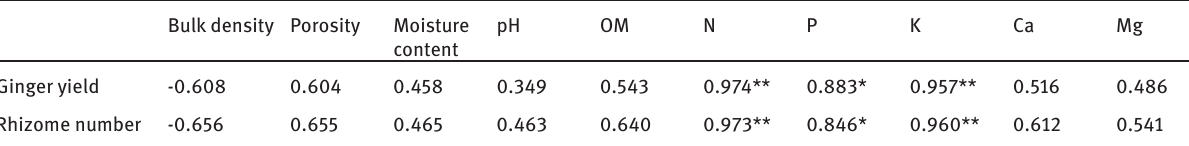
Table 5: Correlation coefficient between yield parameters of ginger and soil physical and chemical properties. Bulk density Porosity Ginger